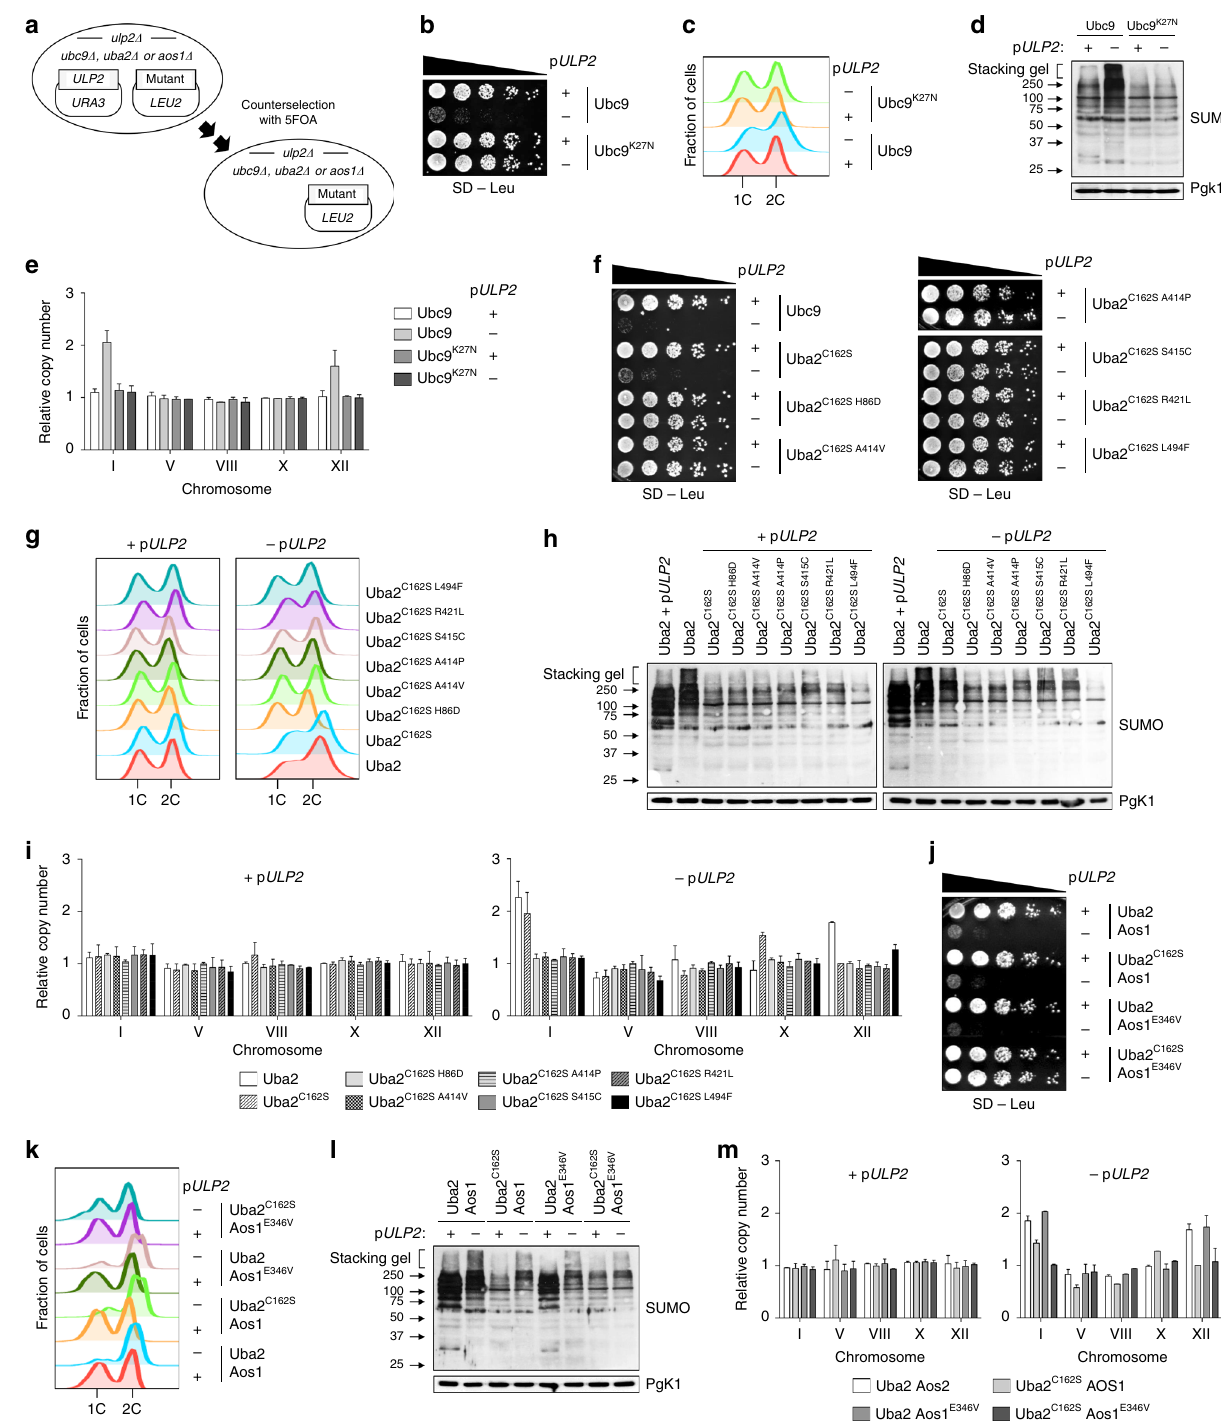
Fig. 6 Mutations in Ubc9, Uba2, and Aos1 suppress ulp2 Δ aneuploidy and other defects. a Plasmid eviction strategy to test ubc9 , uba2 , and uba2 aos1 mutants that were also ulp2 Δ . b , f , j Growth assays of the indicated strains. After spotting cells in fi vefold serial dilutions, SD – Leu plates were incubated for 2 days at 30 °C. c , g , k Flow cytometry analysis of DNA content of the indicated strains. d , h , l Immunoblot analysis of SUMO conjugates in whole-cell lysates. e , i , m qPCR ploidy assays. Error bars indicate the SD calculated from two independent